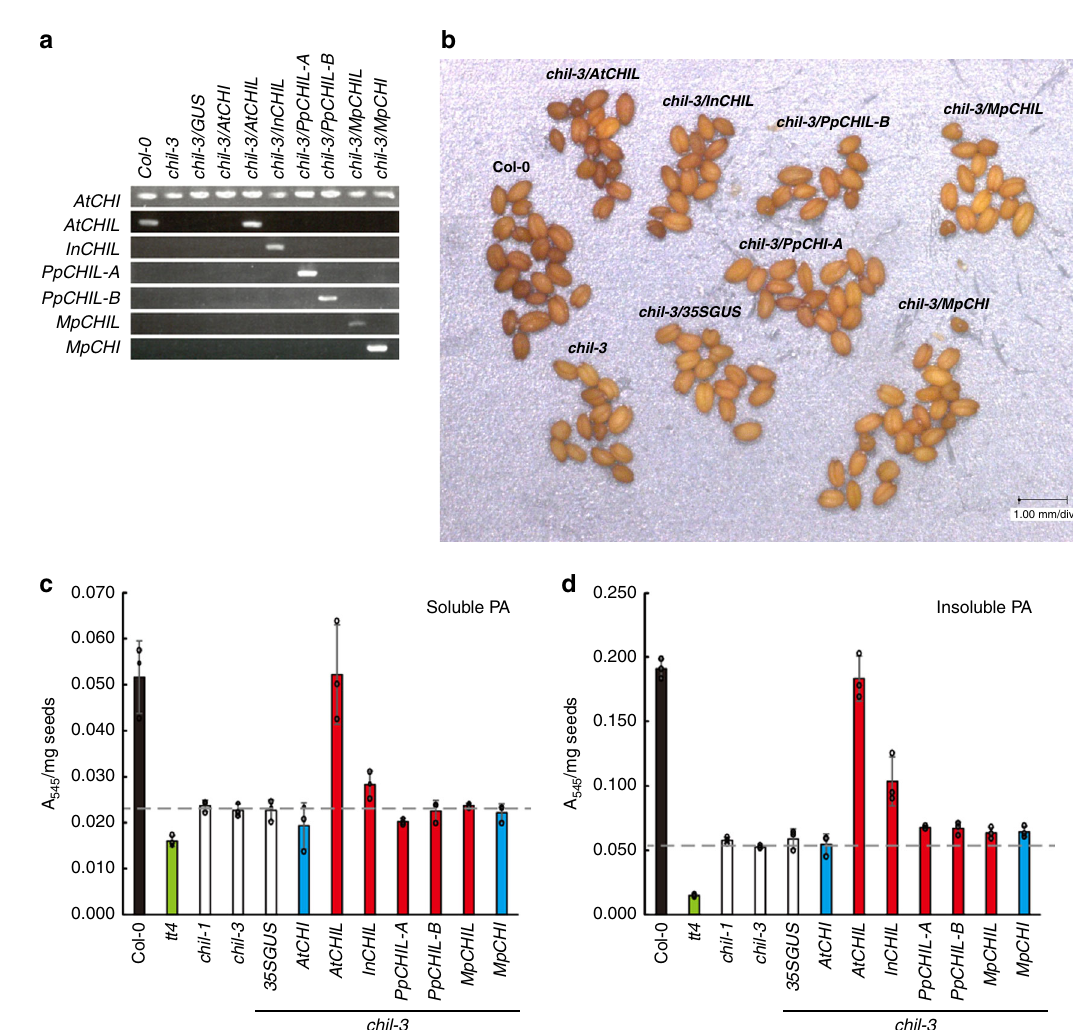
Fig. 4 Complementation of in vivo CHIL function by heterologous CHILs in an A. thaliana chil mutant. a RT-PCR analyses of the wild type (Col-0), the chil-3 mutant, and the complemented chil-3 mutants of A. thaliana for expression of the CHIL gene. b Seed phenotypes of Col-0, the chil-3 mutant, and the complemented chil-3 mutants. c Contents of soluble proanthocyanidins in mature seeds of Col-0 (black bar), the CHS mutant ( tt4 , green bar), the CHIL mutants ( chil-1 and chil-3; white bars), and the complemented chil-3 mutants of A. thaliana with the CHIL gene (red bars), the CHI gene (light-blue bars) or the empty vector with 35SGUS (white bar). d Contents of insoluble proanthocyanidins in mature seeds of the A. thaliana lines shown in ( c ). Data are presented as the average of three independent determinations ( ± standard deviation). The source data of the proanthocyanidin detrminations in ( c ) and ( d ) are provided in the Source Data